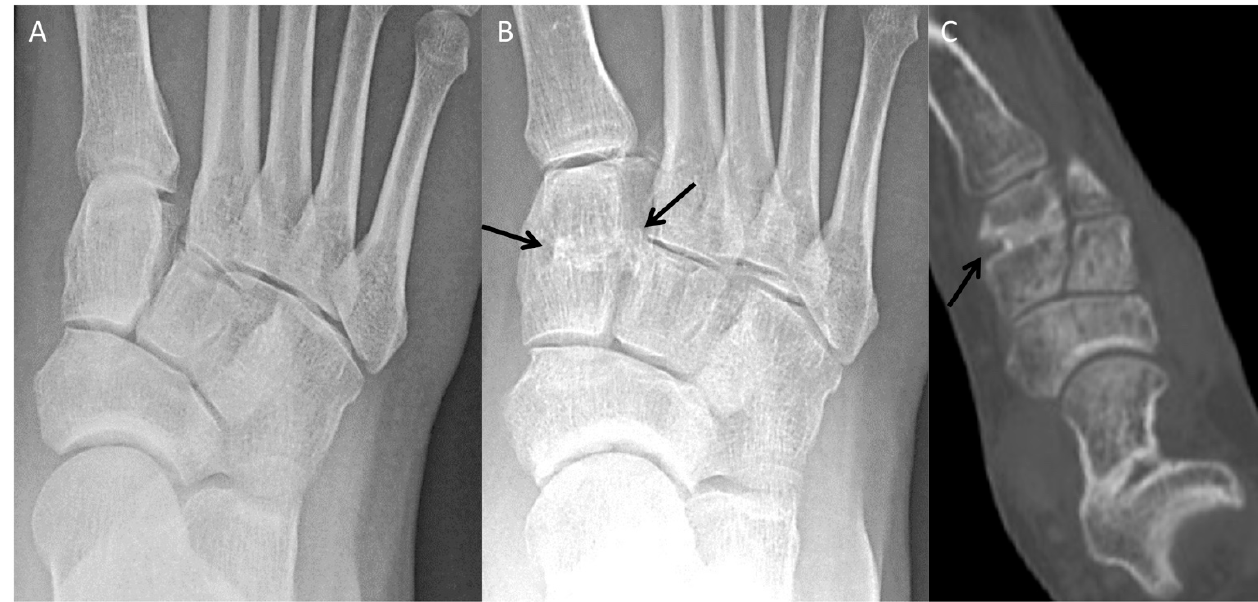
Figure 5. ( A ) Preoperative and ( B ) postoperative AP radiographs, and ( C ) axial CT of the foot demonstrating changes of Cotton osteotomy at the waist of the medial cuneiform with interposition of bone graft material (black